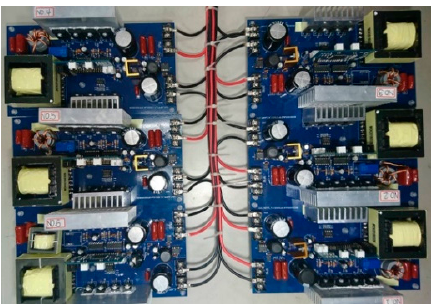
Figure 18. The photograph of the proposed 6 kW LLC converters.